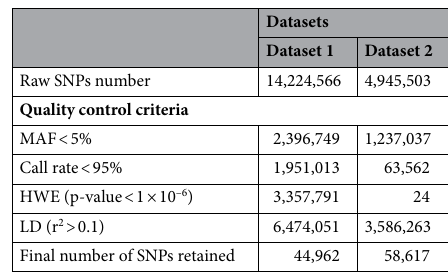
Table 3. Number of autosomal SNPs excluded by filters in dataset 1 (all camel populations) and dataset 2 (Arabian Peninsula dromedary